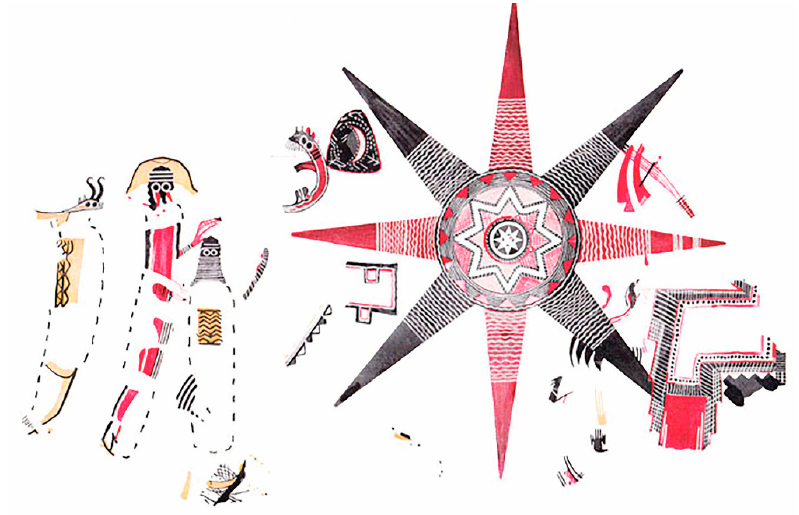
Figure 3. The Star of Ghassul (created by author).